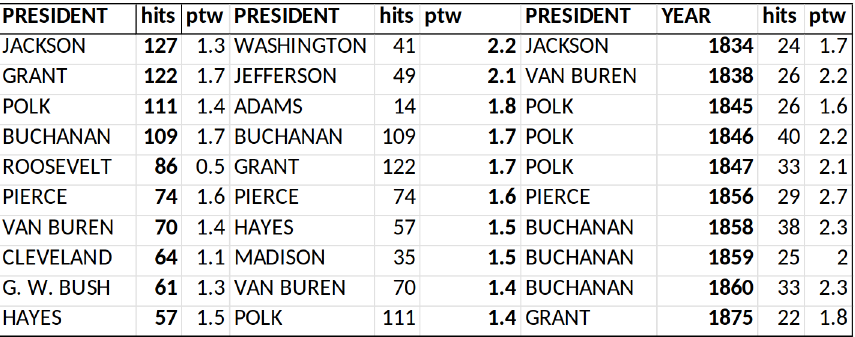
Table 1. The different ranking of the top 10 frequency of citizens in the sub-corpora, respectively by absolute frequency by president (left column), relative frequency by president (middle column) and number of mentions in individual State of the Union addresses (right